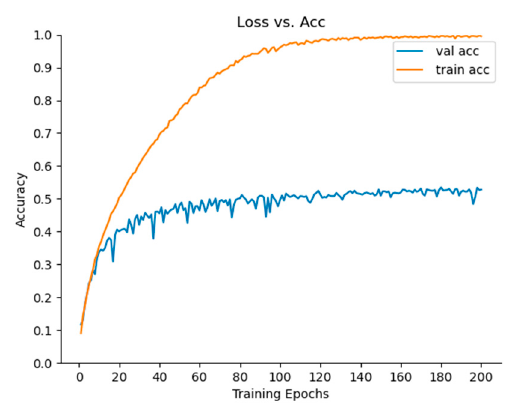
Figure 13. Acc change curve of SDS-Network algorithm iterated 200 times.